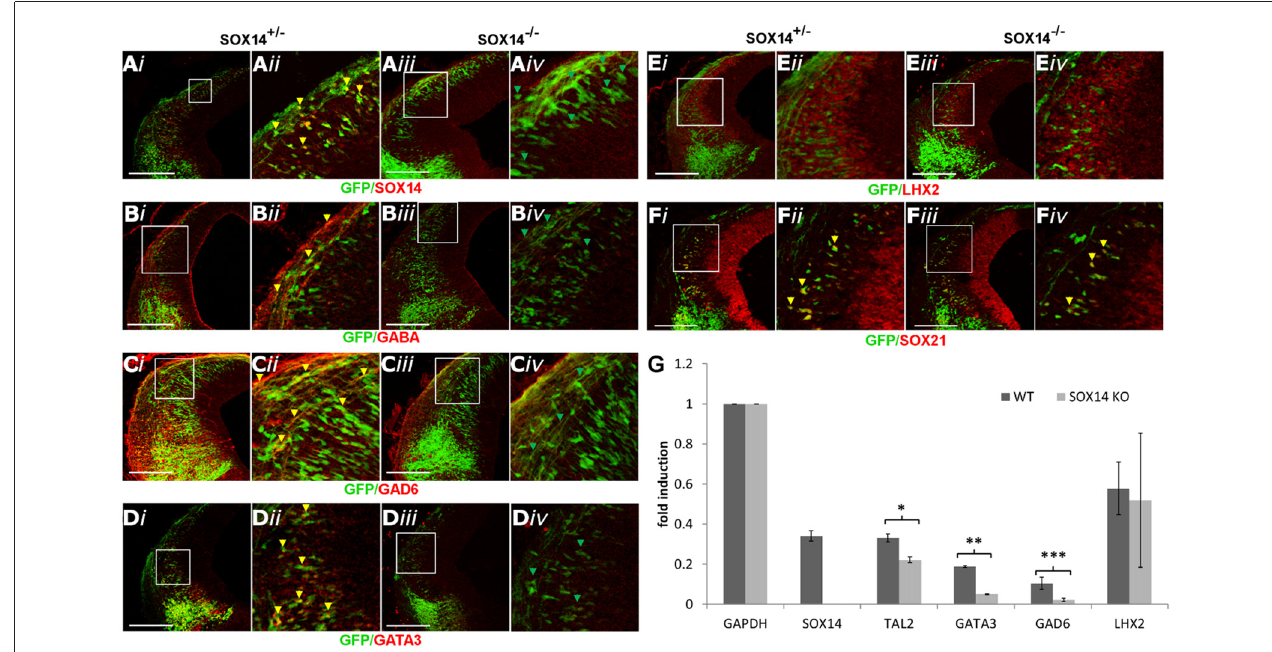
FIGURE 7 | Analysis of the GABAergic and glutamatergic lineages in SOX14 − / − embryos at E12.5. The absence of SOX14 in the knockout embryos was validated by antibody staining (A) .The immunostaining of the GABAergic markers GABA, GAD6 and GATA3 (B,C,E) were shown to be reduced in the knockout embryos ( iii,iv ) in comparison to the heterozygotes ( i,ii ). However, the expression of SOX21 (D) and the glutamatergic marker LHX2 (F) were not affected in the absence of SOX14. These data were confirmed by RT-Q-PCR analysis of embryos at the same age (G) . Data are represented as mean ± SEM. ∗ n = 6 (3 pairs of mice), P = 0.032, DF = 1, Kruskal Wallis test. ∗∗ n = 6 (3 pairs of mice), P = 0.034, DF = 1, Kruskal Wallis test. ∗∗∗ n = 6 (3 pairs of mice), p = 0.021, DF = 1, Kruskal Wallis test. Scale bar, 150 µ